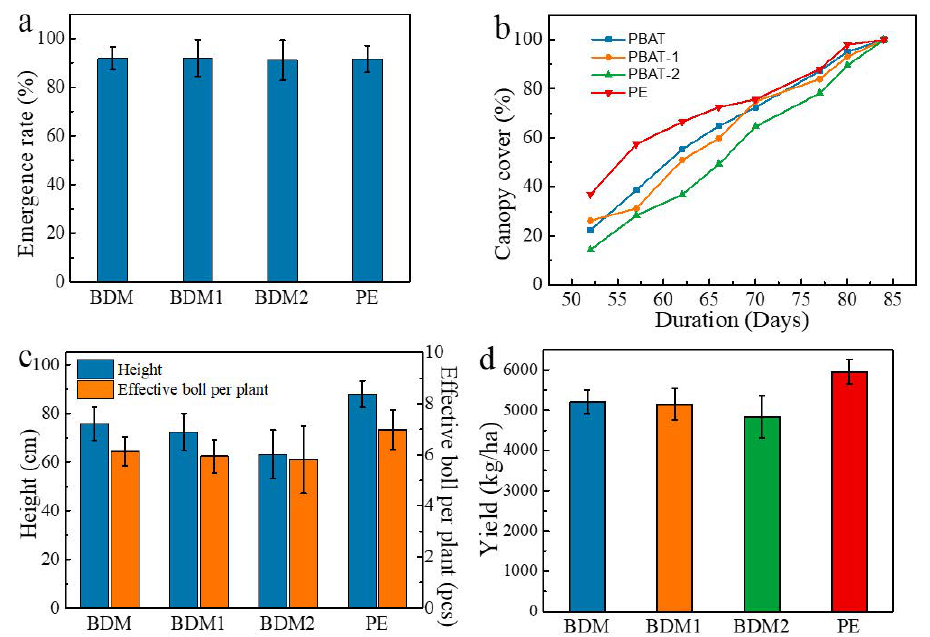
Figure 6. Comparison of emergence rate ( a ), canopy cover ( b ), plant height, boll number ( c ), and cotton yield ( d ) among BDM, BDM1, BDM2, and PE